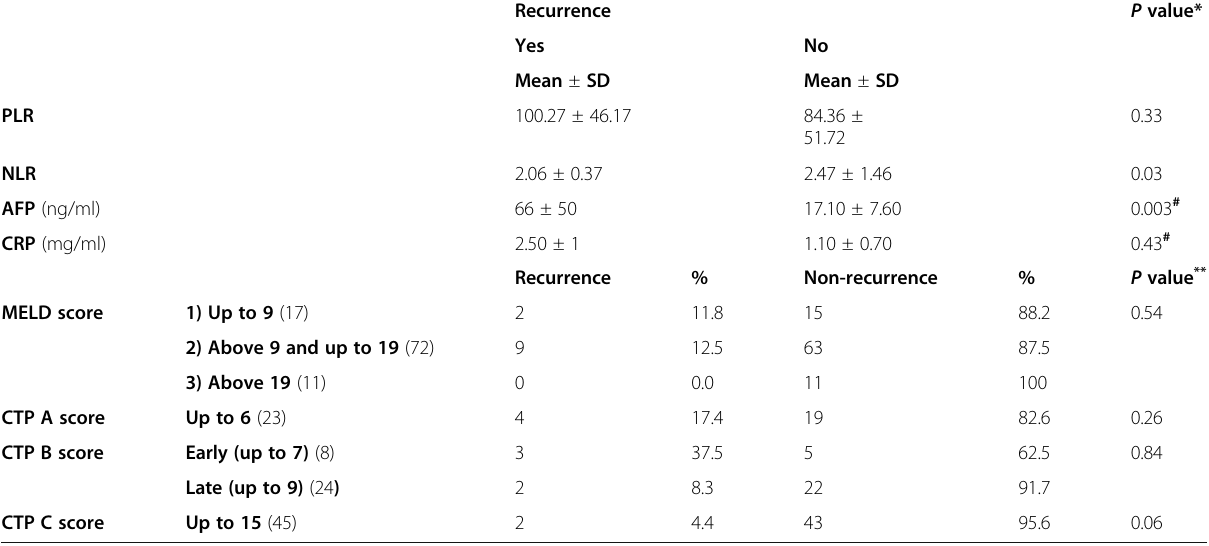
Table 2 The relation between pre-transplantation data and HCC recurrence Recurrence P value*